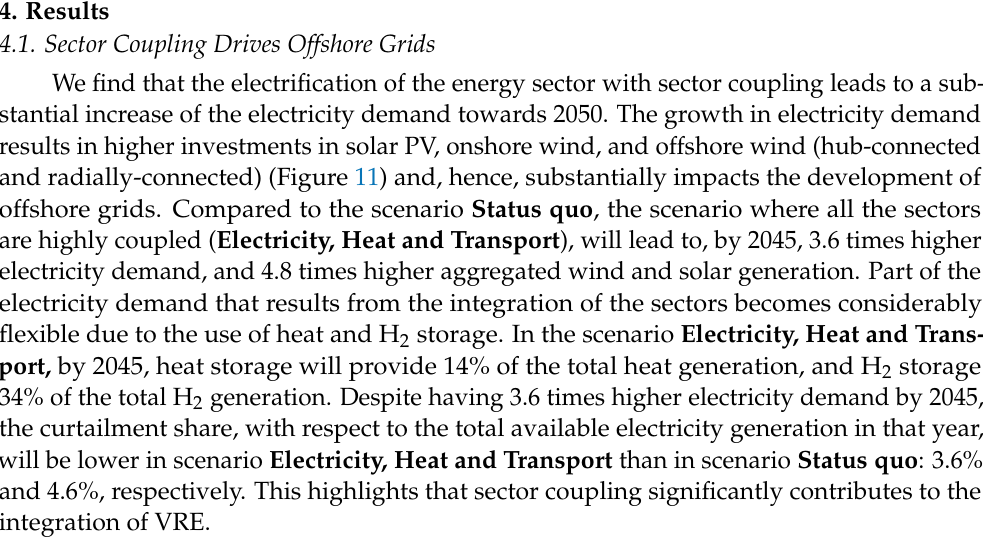
Decarbonization of the Transport